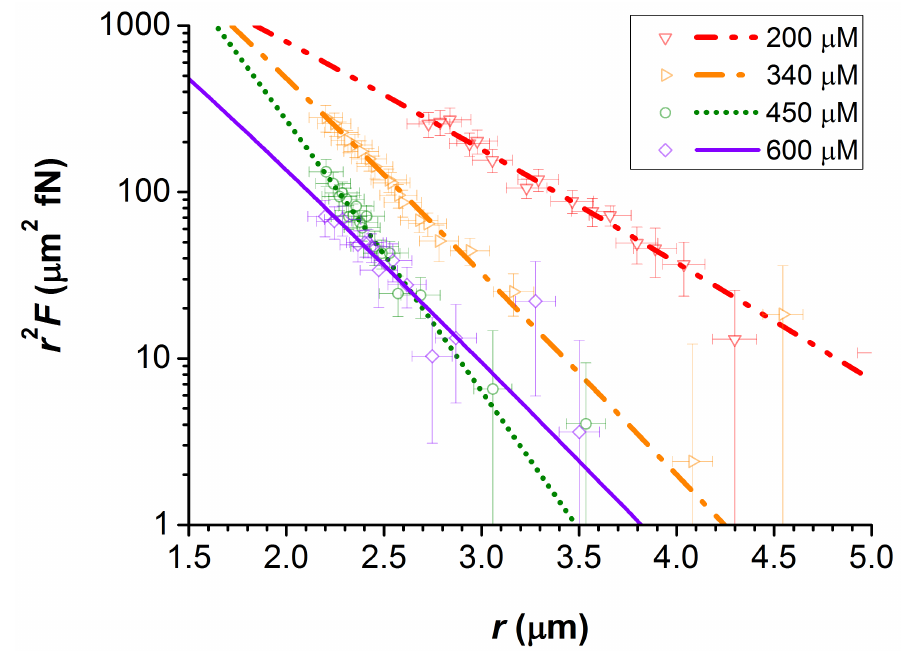
Figure 1. Force profile r 2 F ( r ) as a function of the centre-to-centre separation r for a pair of PMMA = 200, 340, 450, & 600 µ M from blinking optical tweezers measurements. particles in dodecane at n salt The lines depict fits to Equation (2). The gradient of the line is essentially the (negative) inverse screening length − κ . The plot reveals that the measured screening length κ − 1 initially decreases with added salt (as expected), before increasing at 600 µ